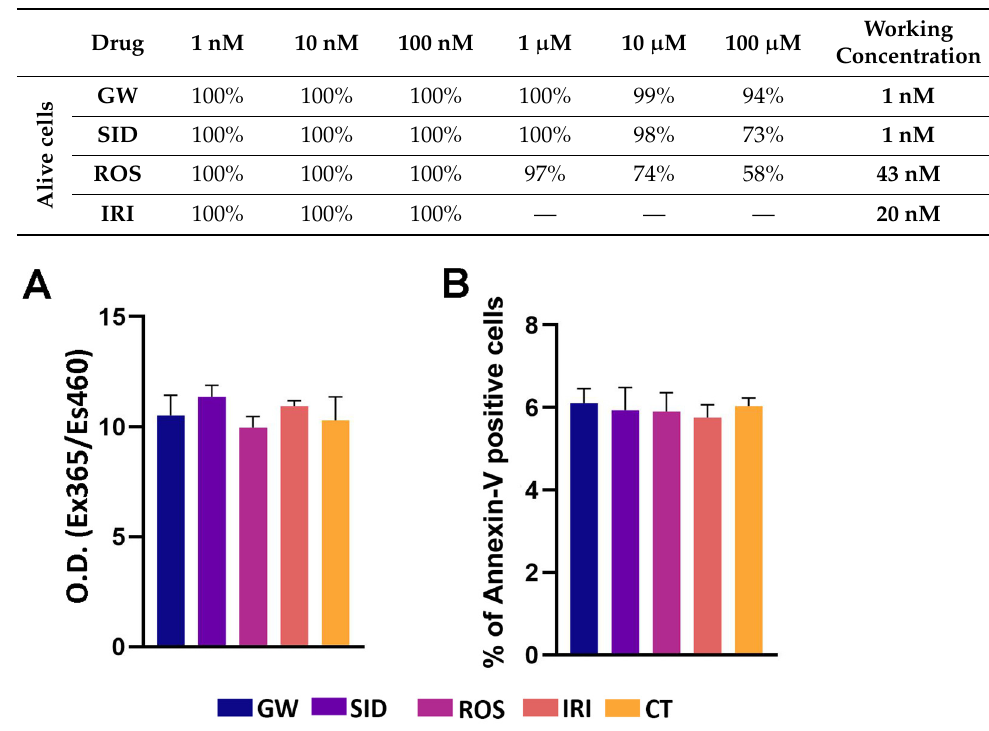
Figure 1. Senescence, and apoptosis detection. ( A ) Senescence evaluation in white adipocytes by 4-methylumbelliferyl- β -d-galactopyranoside (MUG) quantitative fluorescent assay following seven days of drug treatment. The 4-MUG is a β -galactosidase substrate that emits fluorescence when the